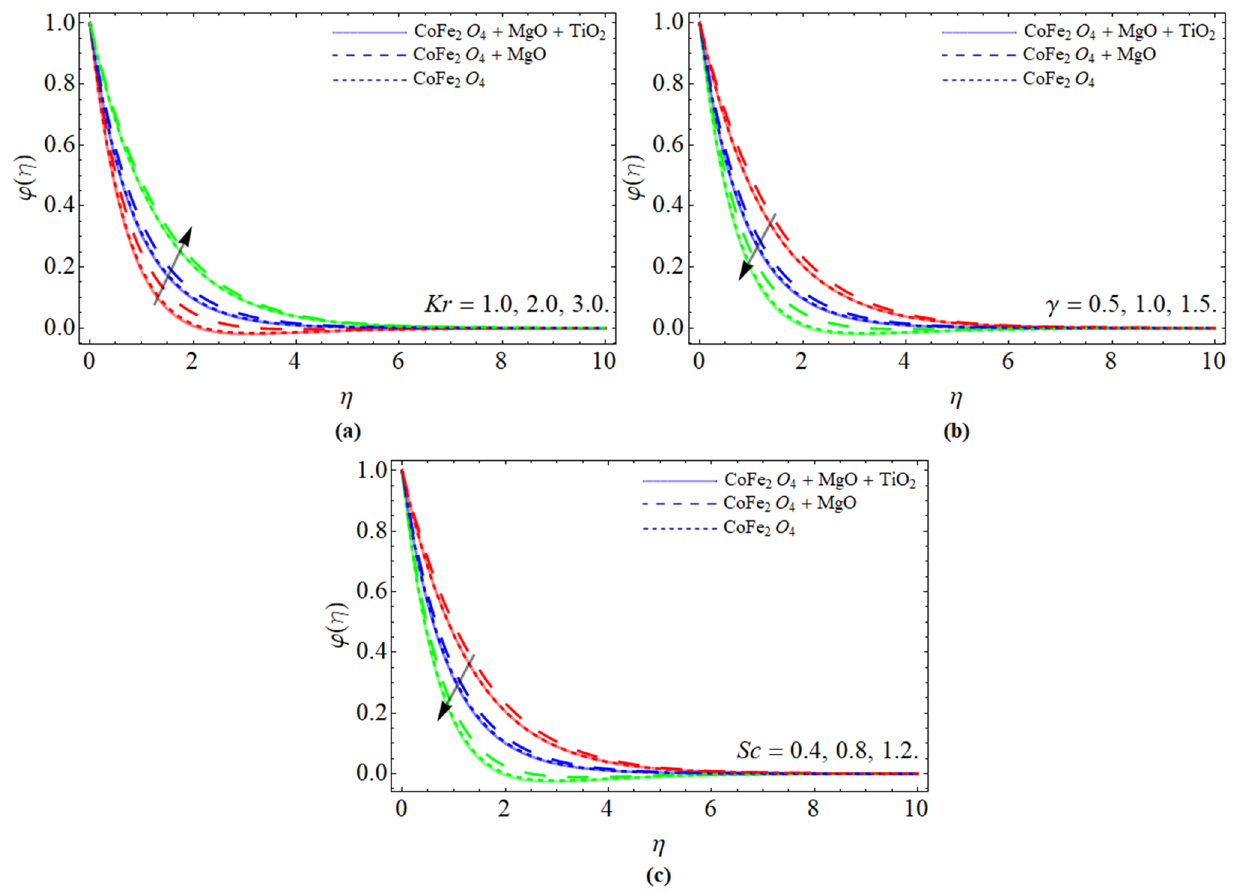
( ) ϕ η Figure 5. The presentation of concentration ϕ ( η ) profile against the variation of ( a ) chemical reaction Figure 5. The presentation of concentration profile against the variation of ( a ) chemical re- γ term Kr , ( b ) curvature constant γ , and ( c ) Schmidt number Sc , and ( c ) Schmidt number Sc . action term Kr , ( b ) curvature constant